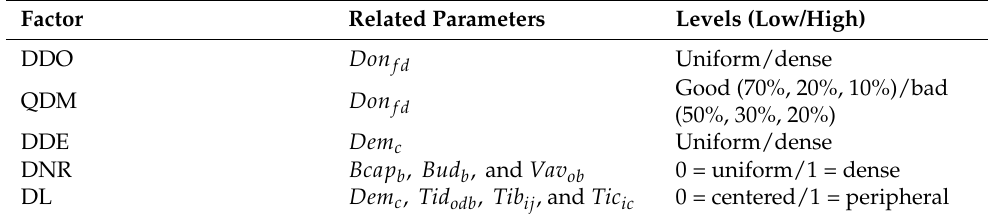
Table 5. Factors and levels considered to generate the scenarios. Factor Related Parameters Levels (Low/High) DDO Don fd